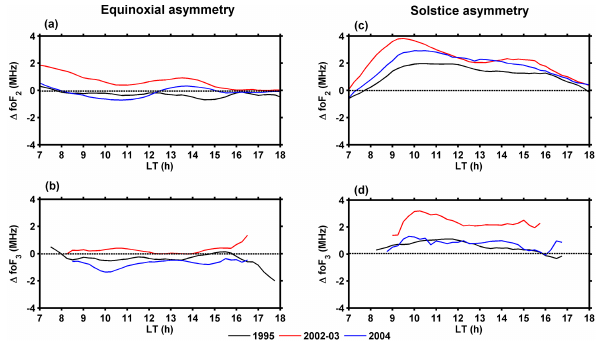
Figure 6. Equinoxial asymmetry (September equinox–March equinox) in (a) f o F 2 and (b) f o F 3 , and solstice asymmetry (winter–summer) in (c) f o F 2 , (d) f o F 3 in different solar activity conditions.